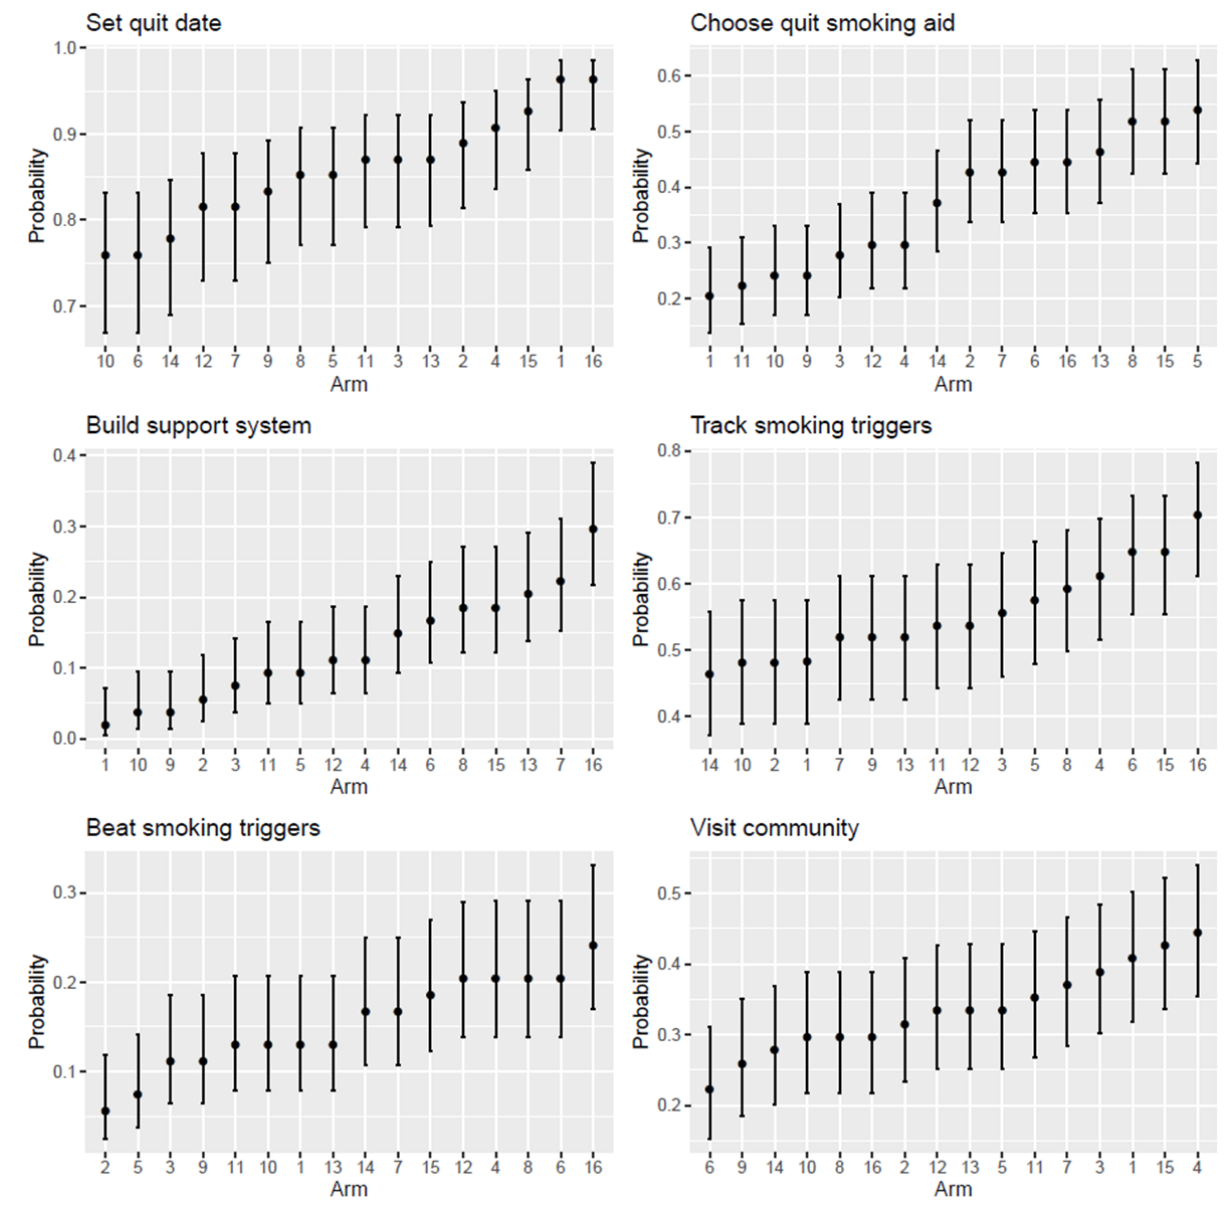
Figure 1. Arm-specific interactive feature utilization